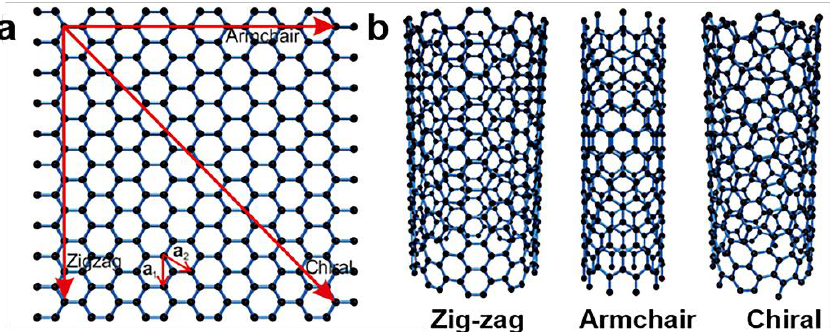
Figure 5. Different forms of single-walled carbon nanotubes (SWCNTs) [35]. ( a ) The chiral vector C determines the tube diameter; ( b ) the three structural forms of SWCNT structures.